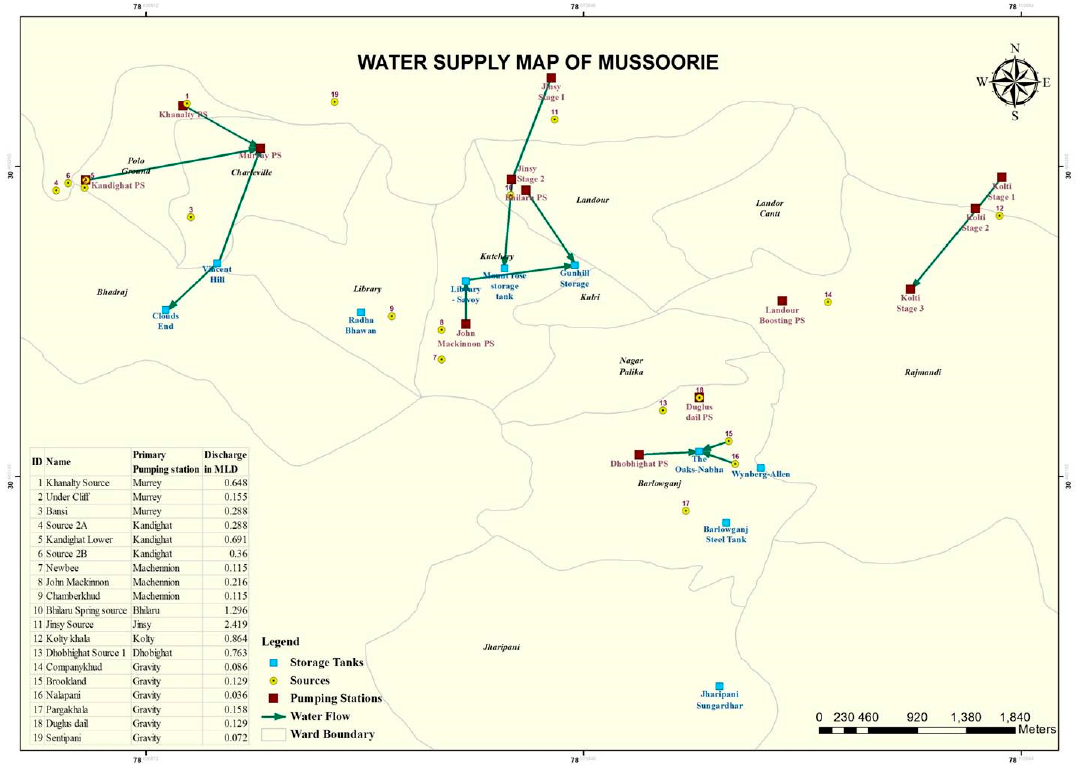
Figure 7. Map showing water pumping points, storage and distribution area.